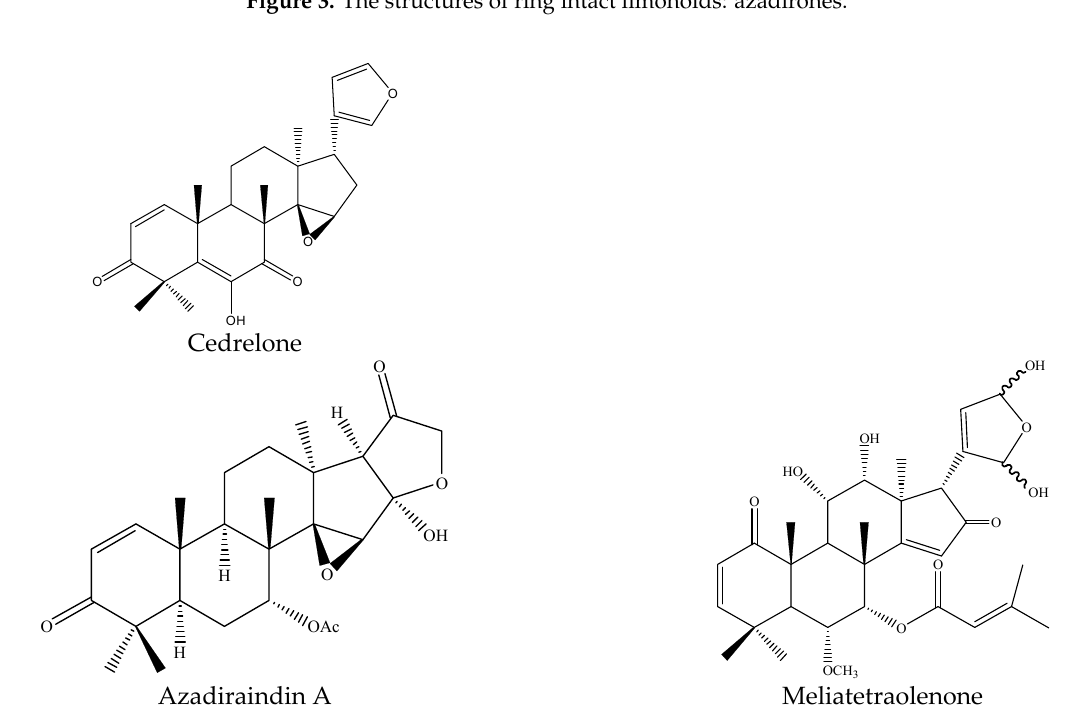
Figure 4. The structure of ring intact limonoids: cedrelone, azadiraindin A, and meliatetraolenone.